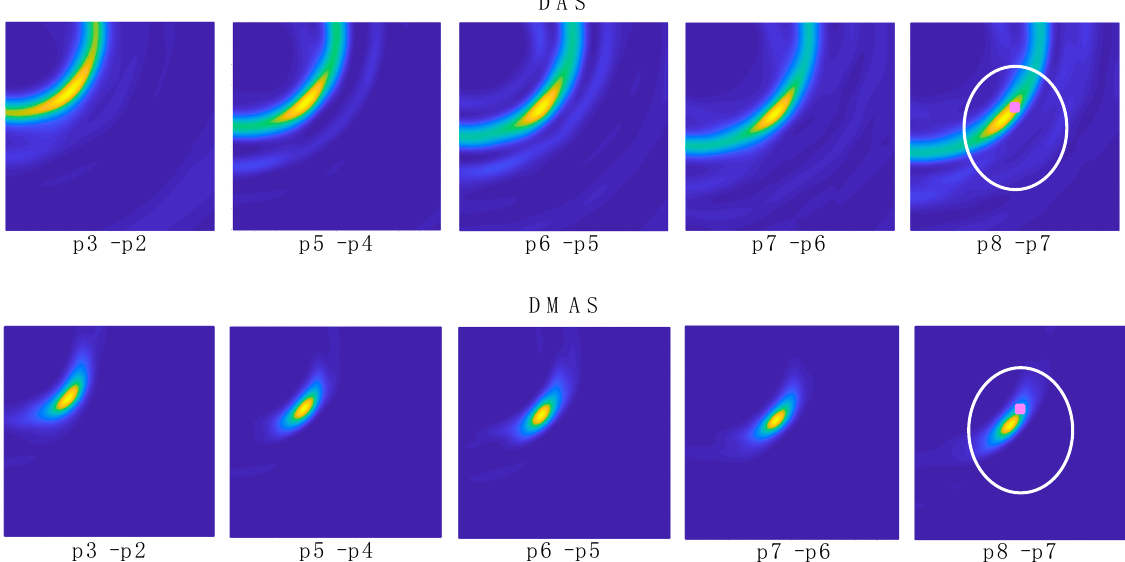
Figure 14. Differential navigation images for a selection of the positions obtained with DAS and DMAS algorithms. The position and shape of the cranium (white) and tumor (pink) are depicted in the last image for reference.